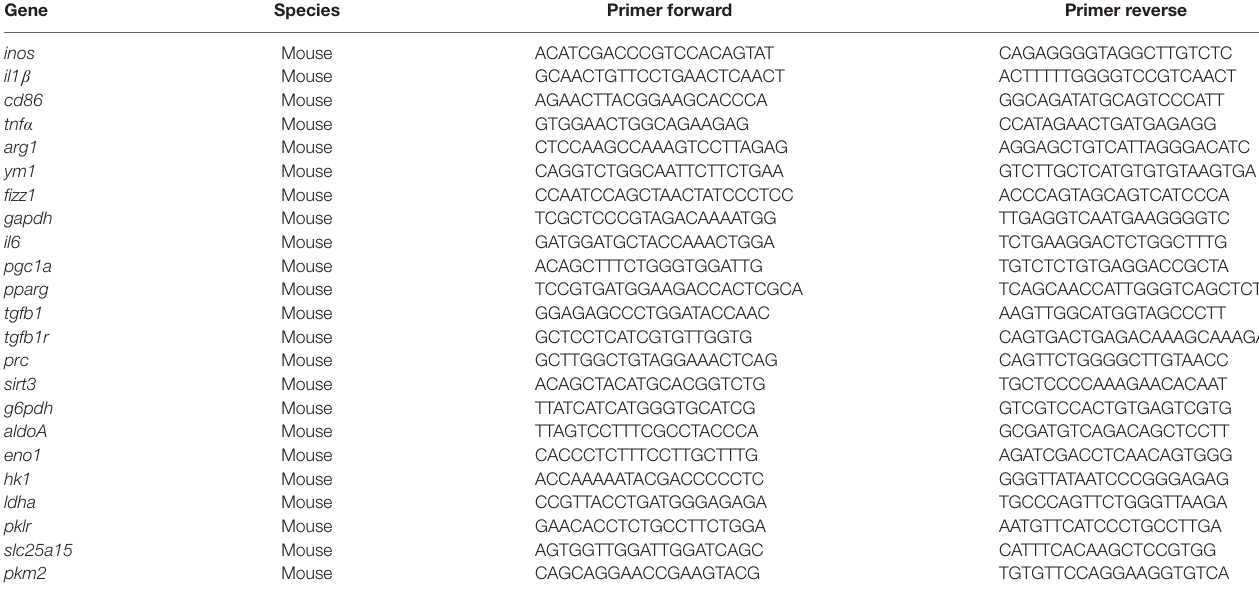
TABLE 1 | Sequences of the primers used for RT-qPCR. Gene Species Primer forward Primer